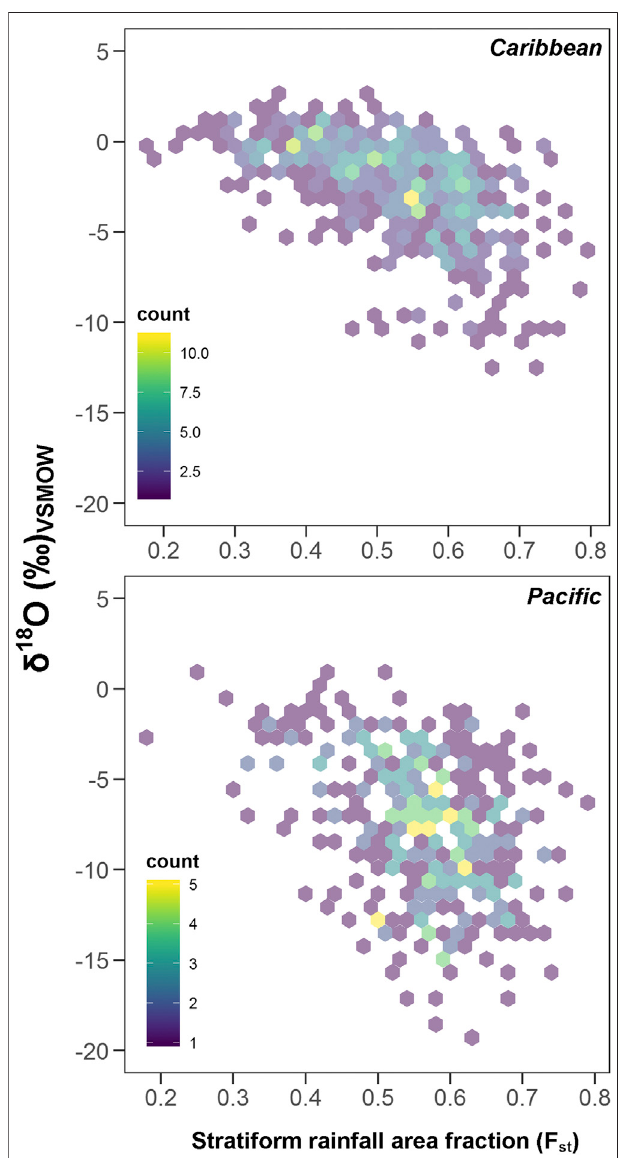
FIGURE 7 | Isotope and stratiform area fraction relationships. (A) Caribbean and (B) Paci fi c domains (Sánchez-Murillo et al., 2019a). Each diagram area was divided into regular hexagons and the color-coded count denotes the number of cases in each hexagon. Figure adapted using data from Sánchez-Murillo et al.